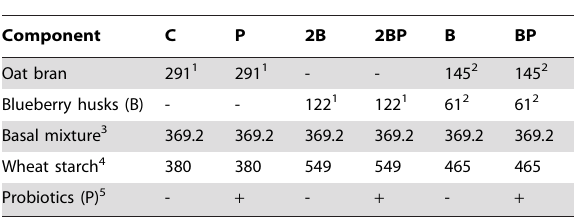
Table 1. Diet composition.